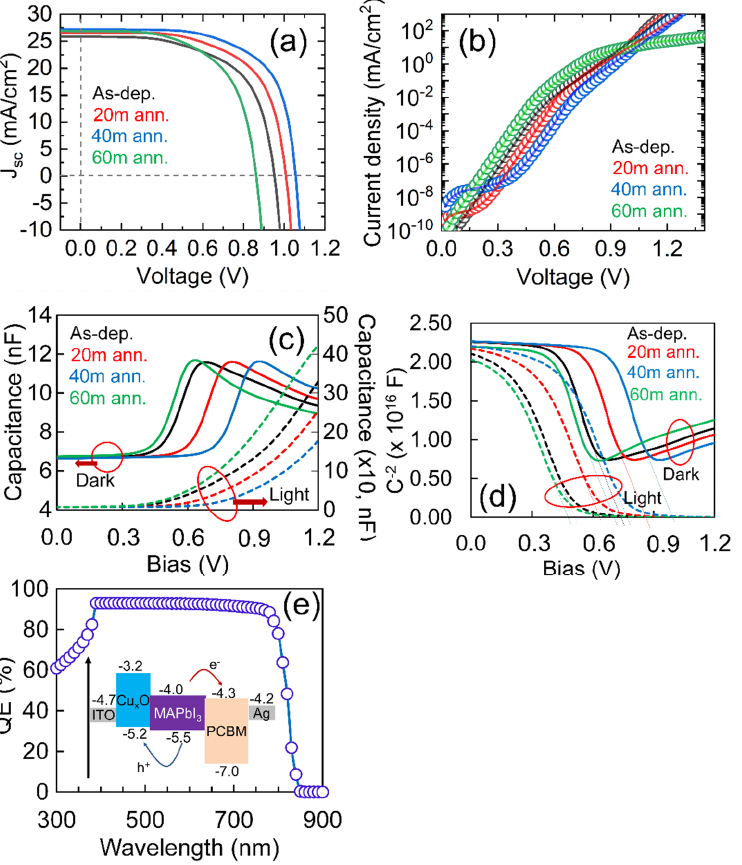
Figure 5. ( a ) The light current density-voltage (J-V) curves, ( b ) Semi-log plot of dark current-voltage (I-V) curve found for PSCs with different Cu x O thin films, ( c , d ) shows the capacitance-voltage curves in light and dark mode for the modeled PSCs and ( e ) shows the external quantum efficiency (EQE) for the highest-efficiency PSC using 40 m annealed Cu x O thin film (inset shows the schematic band diagram of the PSC used in this